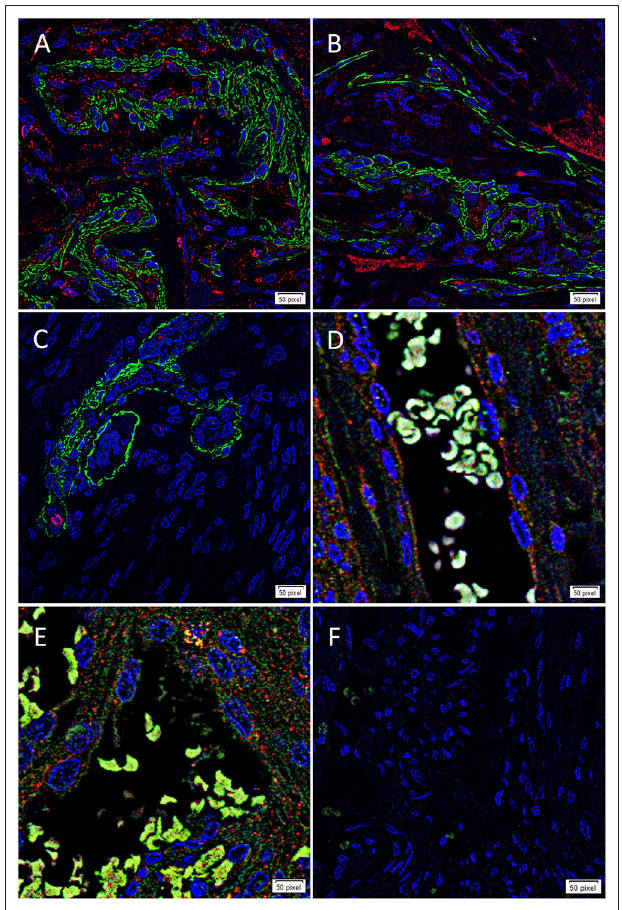
FIGURE 3 | Representative immunofluorescence immunohistochemical staining of WHO grade I meningioma demonstrating the expression of cathepsin B ( A,D , red) and cathepsin D ( B,E , red) on the endothelium and the smooth muscle actin + (SMA; A,B , green) outer pericyte layer. Cathepsin G ( C , red) was expressed by cells outside the microvessels with the outer layer stained positively for SMA. The expression of both cathepsin B and cathepsin D was also demonstrated with the embryonic stem cell marker OCT4 ( D,E , green). A negative control (F) to test the specificity of the fluorescent secondary antibodies was performed on a section of MG. Cell nuclei were counterstained with 4 ′ ,6-diamidino-2-phenylindole ( A–F , blue). Scale bar: 50 µ